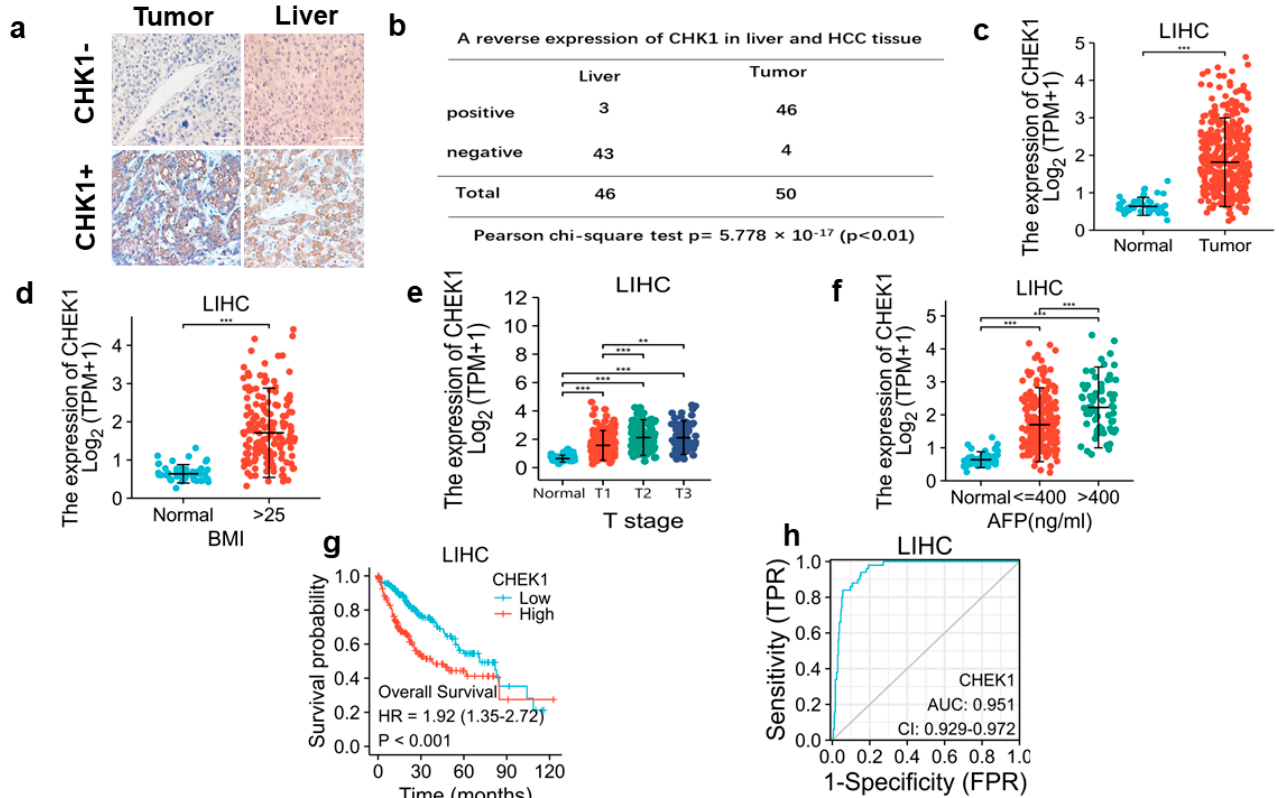
Figure 1. CHK1 is upregulated in HCC tumor and predict advanced tumor stage and poor prognosis. ( a ) IHC staining for CHK1 in HCC tumor ( n = 50) and background liver tissue ( n = 46). The representative IHC images (×200 magnification) are shown for CHK1 protein expression (brown) in tumor and liver tissue. ( b ) Tissue sections of the HCC tumor and liver were IHC stained for CHK1 expression, and their difference was analyzed by Pearson chi-square test ( p < 0.01). Statistical analyses on the CHEK1 mRNA expression in normal liver and HCC tumor ( c ), in patients with normal and high BMI ( d ), in patients with different tumor stages ( e ), and in patients with different AFP levels ( f ) are shown. ( g ) The clinical significance of CHEK1 mRNA expression in HCC overall survival is evaluated through Kaplan-Meier analysis. ( h ) The sensitivity of CHEK1 mRNA expression predicting the prognosis of HCC patients is evaluated by the ROC curve. ( ** p < 0.01, *** p < 0.001).